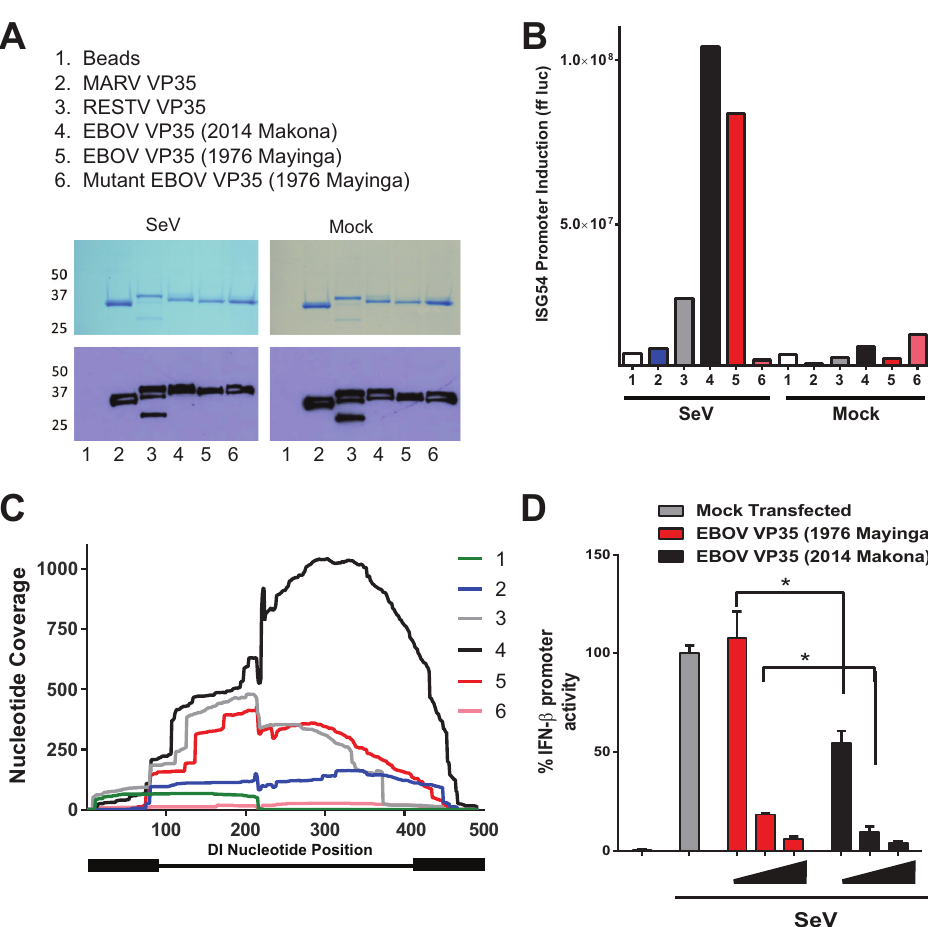
Fig 5. The 2014 EBOV strain and other filovirus VP35 proteins bind the immunostimulatory SeV DI. (A) A key describingeach of the experimental conditions tested with correspondingnumbers for panels A-C. “Beads” refers to the control sample in which cells that were transfected with empty pCAGGS vector only. Protein stain (top) and immunoblot against FLAG tag (bottom) of the immunoprecipitatedsupernatant showingthe purity and relative expressionlevels of the VP35 proteinsfrom MARV, RESTV, EBOV 1976 (Mayinga), EBOV 2014(Makona) and the VP35 EBOV RNA-binding mutant (Mayinga). (B) Ability of RNA purifiedfrom each VP35 in the presence(left) or absence (right) of SeV infectionto stimulate the ISG54 promoter. (C) Next-generation sequencing and mappingto the SeV DI genome. RNA associatedwith each VP35 variant was purifiedand subjectedto Illumina sequencing. The graph depicts nucleotide coverage(Y- axis) at each positionof the SeV DI genome (X-axis). Thick black regionson each end of the DI diagram representself-complementary sequencesthat presumably base-pair.(D) Comparisonof IFN- β inhibition by the Mayingaand Makona EBOV VP35 proteins from the 1976 and 2014 outbreaks, respectively. A * between groupsdenotes the results of a T-test where p <